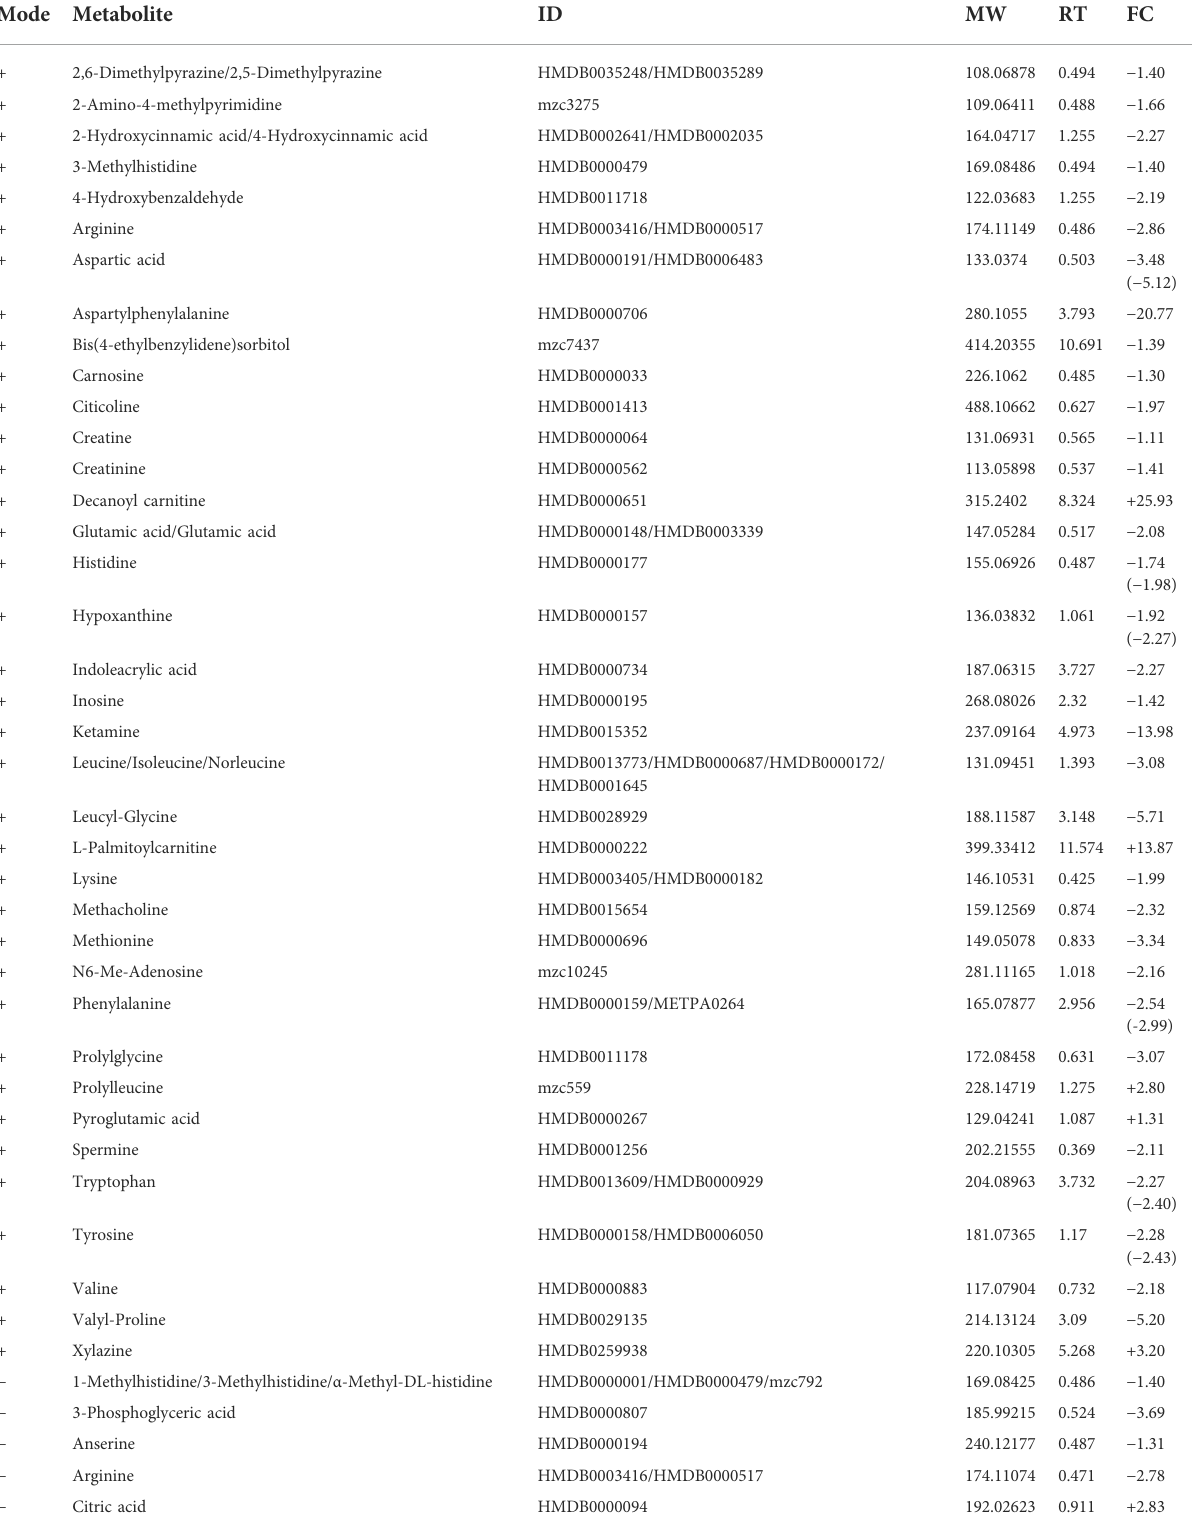
TABLE 2 List of metabolites in OC against